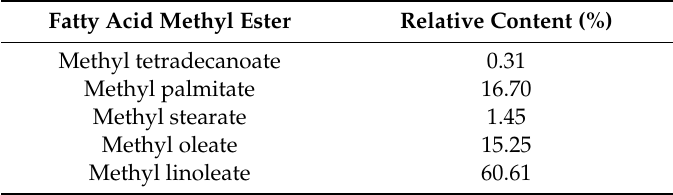
Table 3. Representative methyl esterification products of cottonseed oil by Gas Chromatography–Mass Spectrometry (GC–MS)